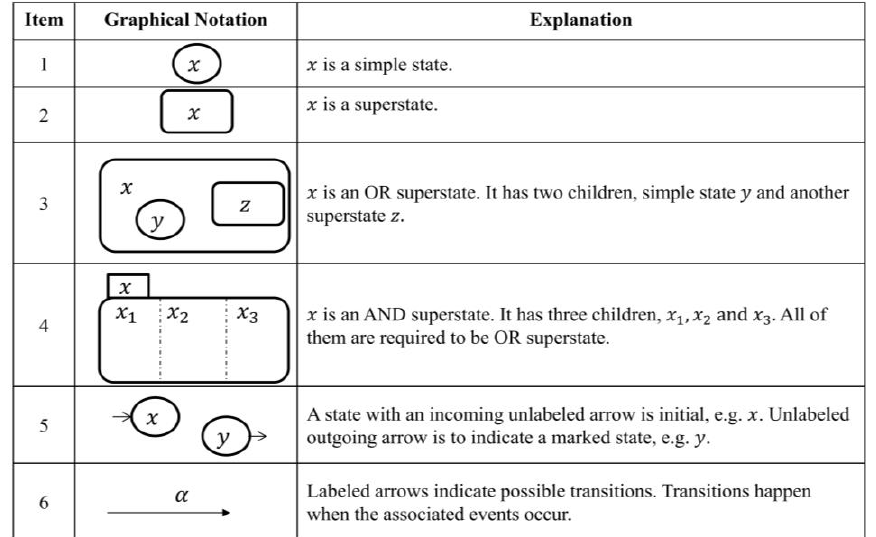
Figure 6. The main graphical notation of the transitional model [32].